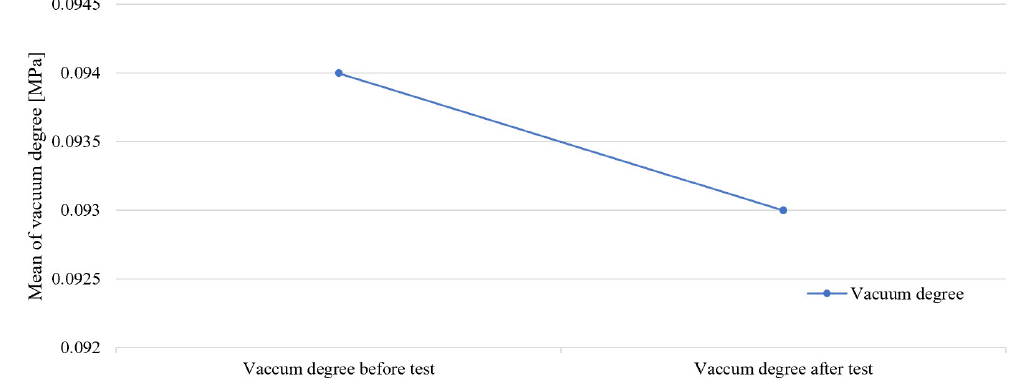
Figure 11. Mean plot of vacuum degree for analysis of variance.